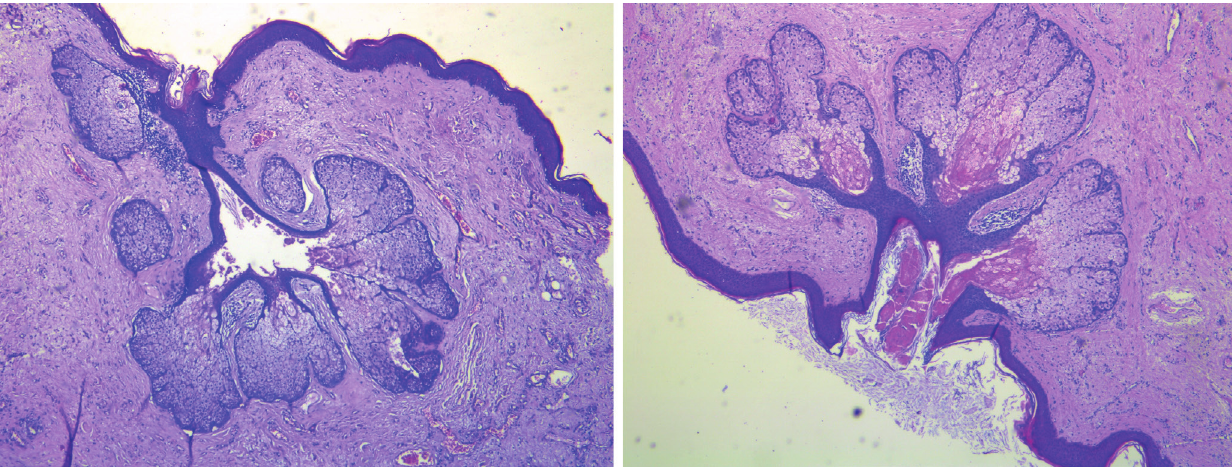
Figure 5. Histopathological examination, HE,